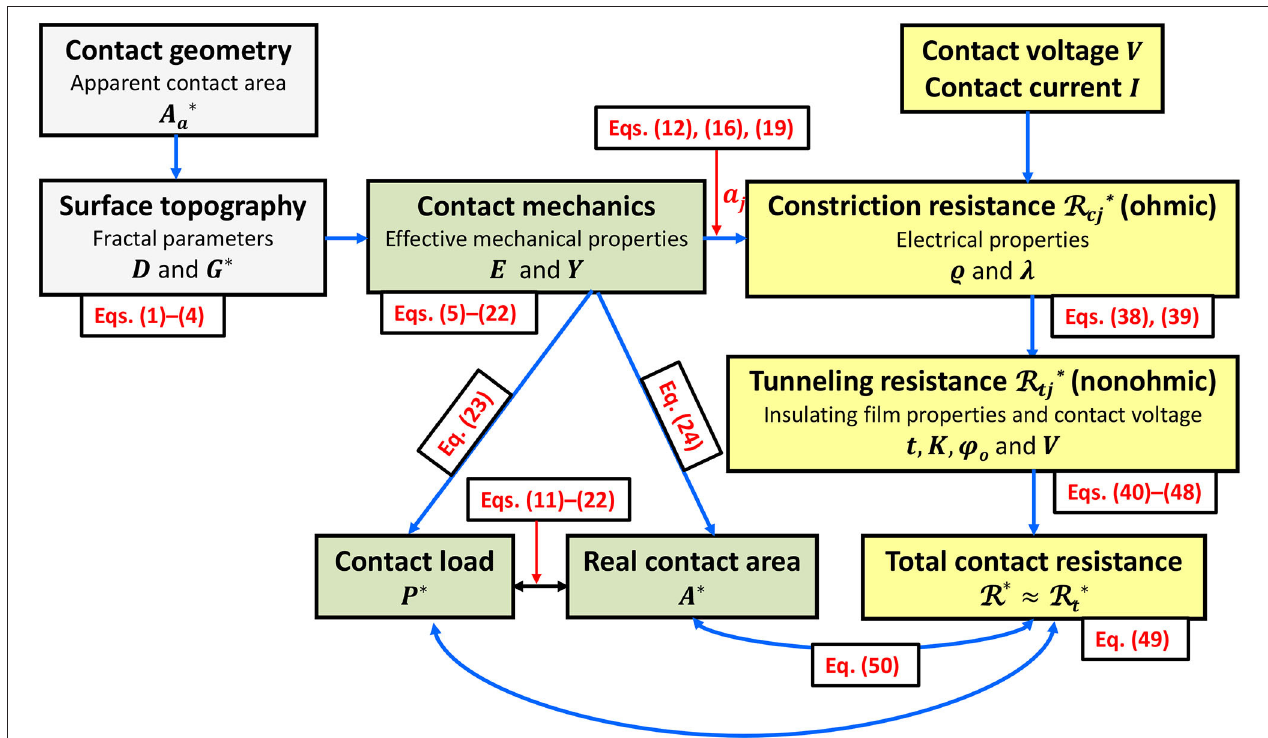
FIGURE 12 | Electromechanics flow chart for rough (fractal) contact interfaces. Dimensionless parameters are indicated with an